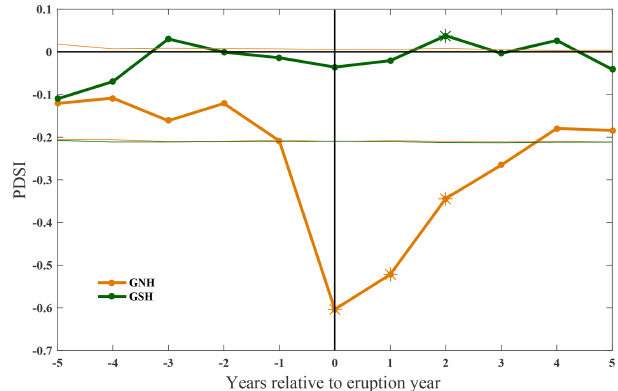
Figure 3. Temporal SEA results of summer (JJA) mean PDSI cor- responding to the GNH (yellow line) and GSH (green line) vol- canic classifications in 1300–1850CE in the Asian monsoon region (8.75 ◦ S–56.25 ◦ N, 61.25–143.75 ◦ E). The thinner lines stand for the relative Monte Carlo model results at the 95% confidence level. The asterisks represent the years that passed the Monte Carlo model tests at the 99% confidence level. Year 0 represents the eruption year identified by the volcanic-forcing index; negative and positive years represent relative years before and after the